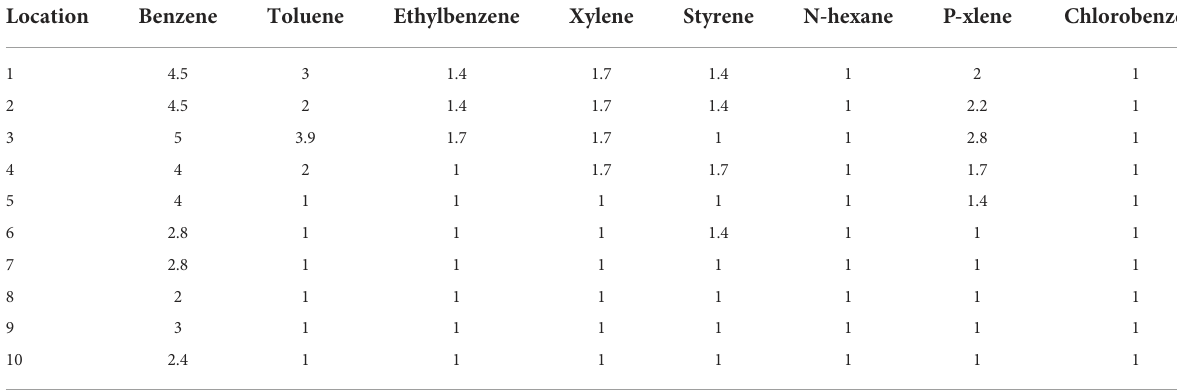
TABLE 9 The health risk assessment of VOCs using SQRA in study sites. Location Benzene